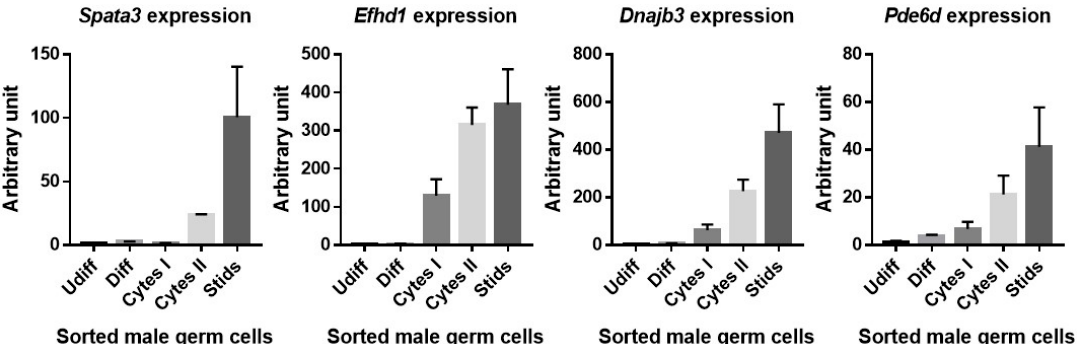
Figure 7. Expression level of four genes during the different stages of spermatogenesis. To determine the stage of spermatogenesis in which these four genes are expressed, the different male germ cell populations were separated by flow cytometry and the expression levels were measured by qRT-PCR. Undifferentiated (Udiff), differentiated (Diff) spermatogonias, primary (Cytes I) and secondary (Cytes II) spermatocytes, spermatids (Stids).